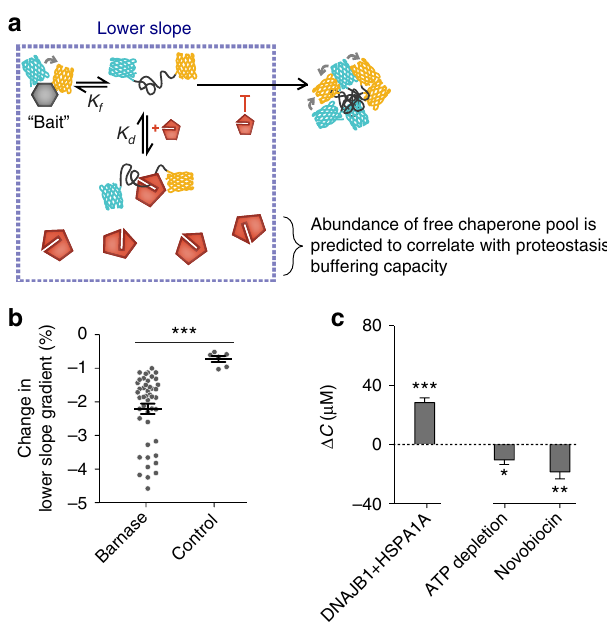
Fig. 4 Quantifying proteostasis by changes in latent chaperone concentration available for holdase activity ( Δ C ). a Conceptual framework for how chaperone levels affect barnase foldedness. b Changes in Lower- slope gradients of the barnase mutants (data points show individual replicates of each mutant) vs. a FRET-positive negative control (mTFP1 cp175-Venus cp173 fusion lacking the barnase kernel; data points show individual replicates) when co-expressed with HSP40 and HSP70 chaperones (DNAJB1 and HSPA1A respectively) relative to baseline conditions (Y66L EGFP co-expression). Means ± SEM shown. c Effect of toggling proteostasis on changes in available chaperone capacity ( Δ C ). Plots show means ± SEM of the 12 barnase mutants when coexpressed with DNAJB1 and HSPA1A (compared to Y66L EGFP control; left panel), or treated with proteostasis-modulating drugs (compared to untreated control). Wilcoxon signed rank tests results coded as *** p < 0.001, ** p < 0.01, * p <